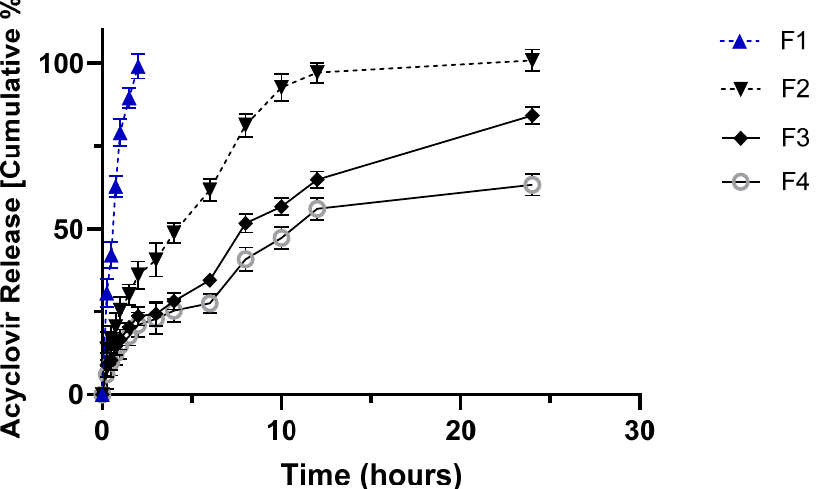
Figure 2. In vitro release profile of acyclovir from HPMC tablets (F-1 to F-4) in 0.1 N HCl (pH 1.2) from zero to two hours, after which 200 mL of 0.2 M sodium phosphate tribasic solution was added to reach a final pH of 7.4 kept for the remaining 24 h. Please refer to Table 7 for tablets’ composition.